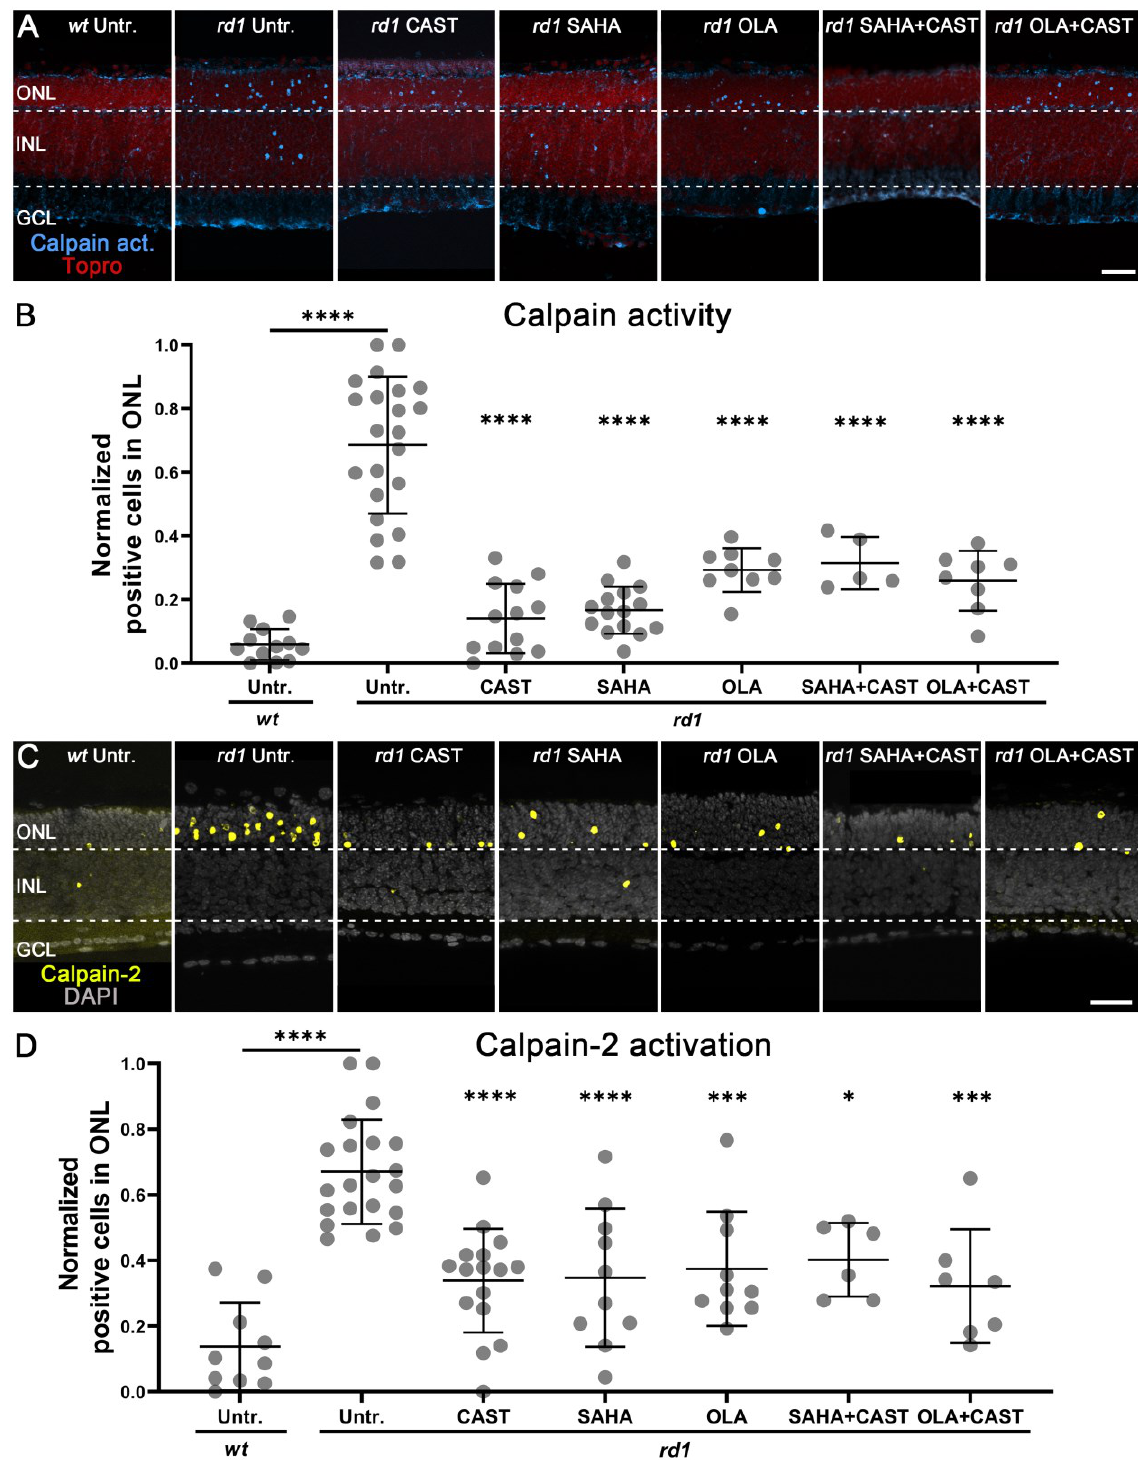
Figure 2. Effects of mono- and combination therapies on photoreceptor calpain activity. The activity of calpains and activation of the calpain-2 isoform were assessed in wild-type ( wt ) and rd1 retinal ex- plant cultures, treated with inhibitors targeting calpain (CAST), HDAC (SAHA), or PARP (OLA), or inhibitor combinations. ( A ) Retinal cross-sections from the different treatment groups were stained with the in situ calpain activity assay (blue). ToPro (red) was used for nuclear counterstaining. ( B ) Scatter plots showing the normalized percentages of calpain-positive cells in the outer